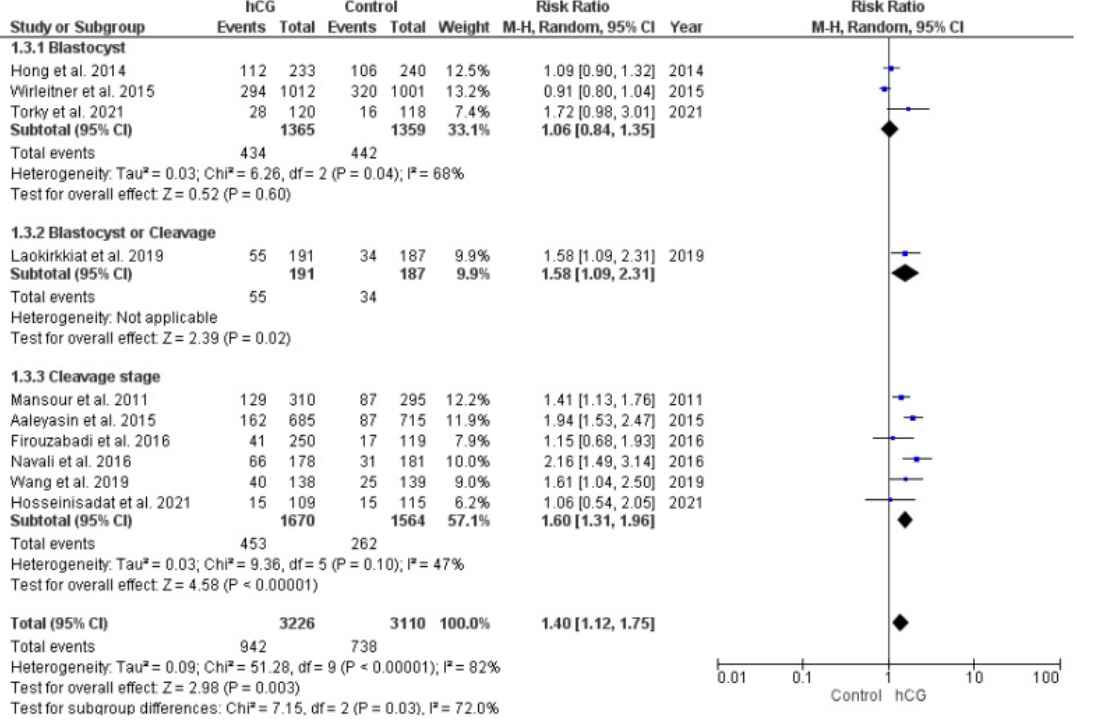
Five studies reported data concerning the live birth rate (total participants = 2238). The live birth rate was comparable in the two groups (Figure 5).